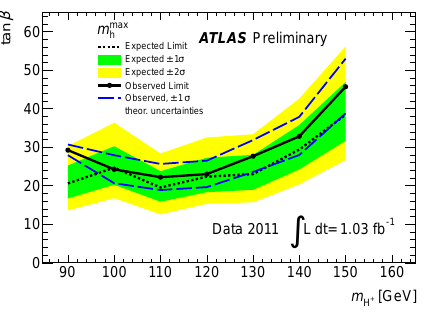
Fig. 4. Limit from τ + jets events for H + production in the m H + tan β plane ( m max H